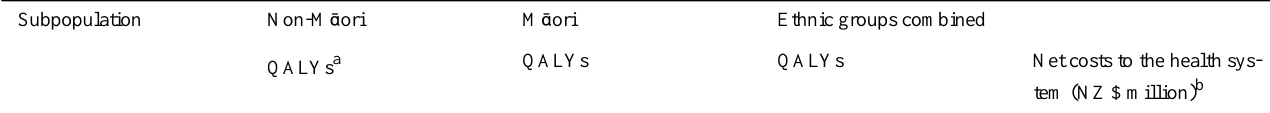
Table 4. Health gain (in quality-adjusted life-years) and health system costs saved over the life course from the promotion of smartphone apps for weight loss among the New Zealand population alive in 2011 (population N=4.4 million; 3% discounting; 95% UI in brackets). Results presented for those older than 25 years as relative risks for the associations between risk factors and disease start at age 25 years.